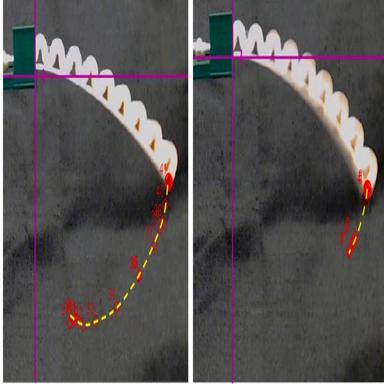
Dynamic displacement analysis. a). under 10 psi, 0.5 Hz, and unload condition; b). under 10 psi, 7 Hz, unload condition. The trajectory of the tip of the actuator is described by the yellow dotted line.